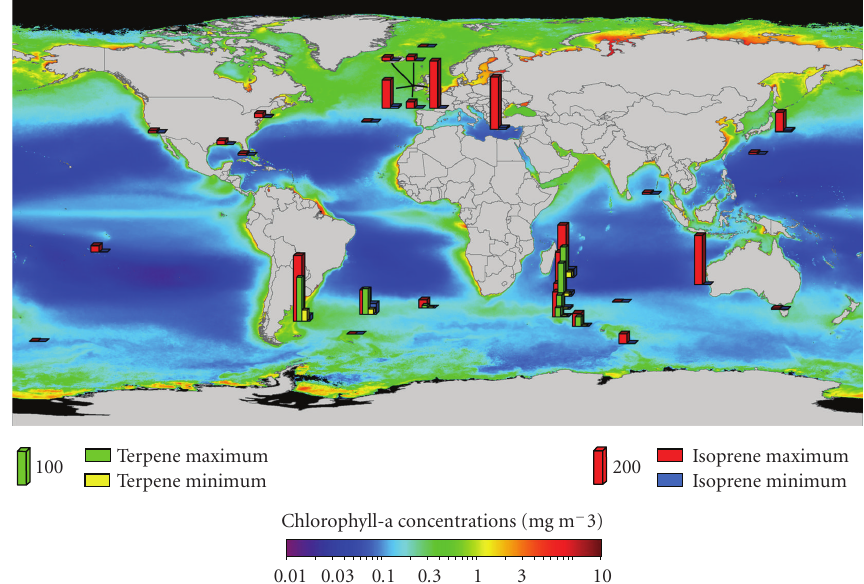
Figure 3: Marine Isoprene and Monoterpene Atmospheric Mixing Ratios. Mixing ratios in pptv. Otherwise as for Figure 1. Figure 3 only: one high point [39] removed to bring other points in